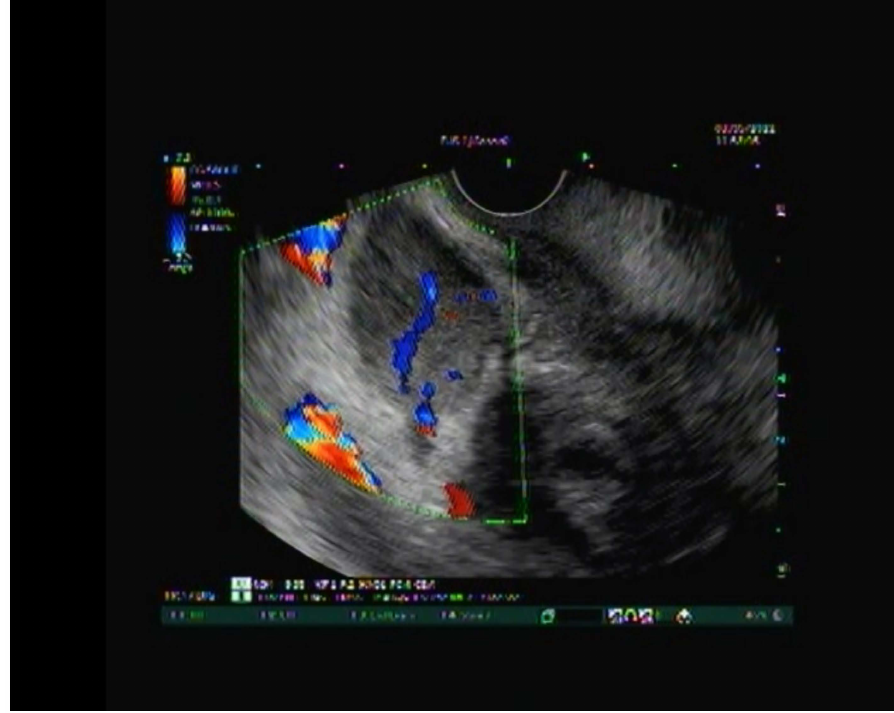
Figure 5. EUS—mass-like enlargement of the pancreatic